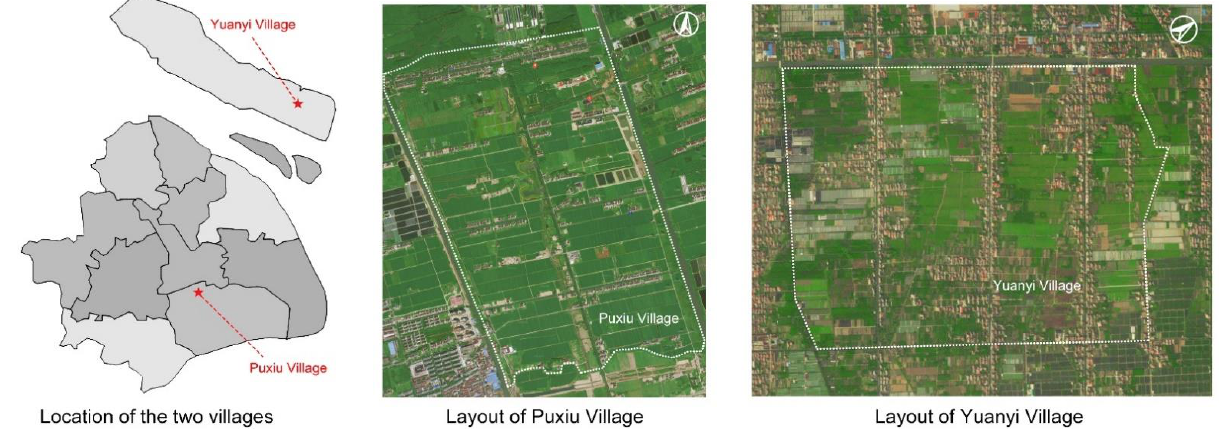
Figure 1. Location map and layout of Puxiu and Yuanyi village.